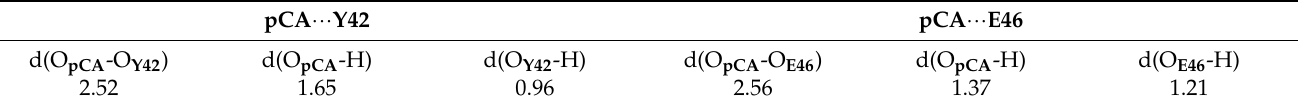
Table 1. Distances, in Å, measured between the atoms involved in the short hydrogen bonds (HBs) with the chromophore ( p -coumaric acid: pCA) in PYP active